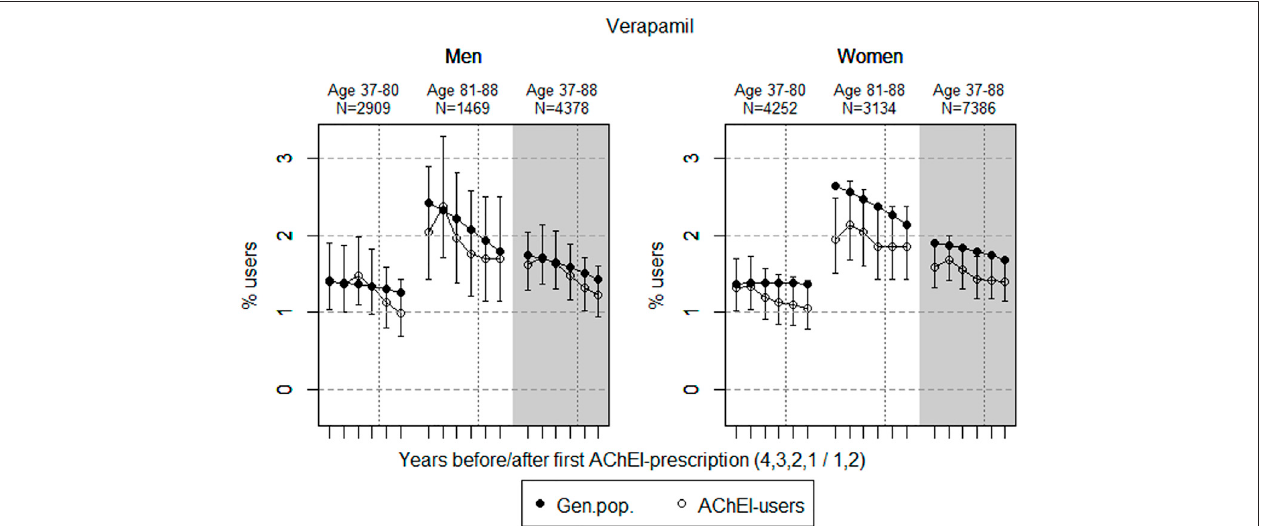
FIGURE 3 | Open circles: Proportion of men and women, respectively, of the study population who fi lled at least one prescription of verapamil (ATC C08DA01) in the 4 years before AChEI initiation and the 2 years after with 95% con fi dence intervals. Bullets: The corresponding age adjusted proportion in the general population. Dashed vertical lines indicate AChEI initiation. The size of each age group in the study population is given on top.